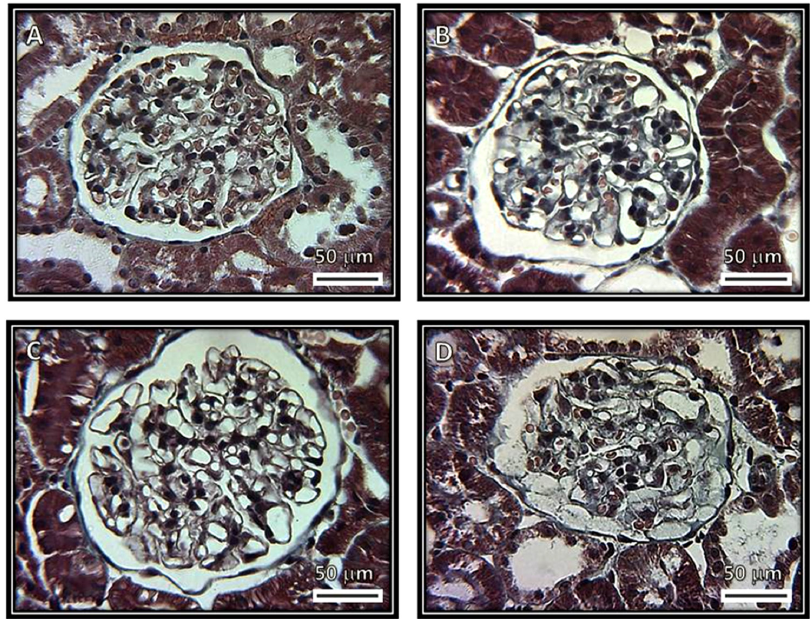
Figure 3. Representative photomicrographs of rat renal cortexes. Images show glomeruli from ( A ) control, ( B ) kidneys from rats injected with saline solution and ( C ) rats that received serum from healthy subjects. No abnormalities were observed under light microscopy in these groups. There are open capillary loops and conserved spaces. ( D ) Rats that received serum from patients having collapsing glomerulopathy. Glomeruli show podocyte hypertrophy, retraction of capillary loops and prominent visceral cells (Masson staining, 400×).